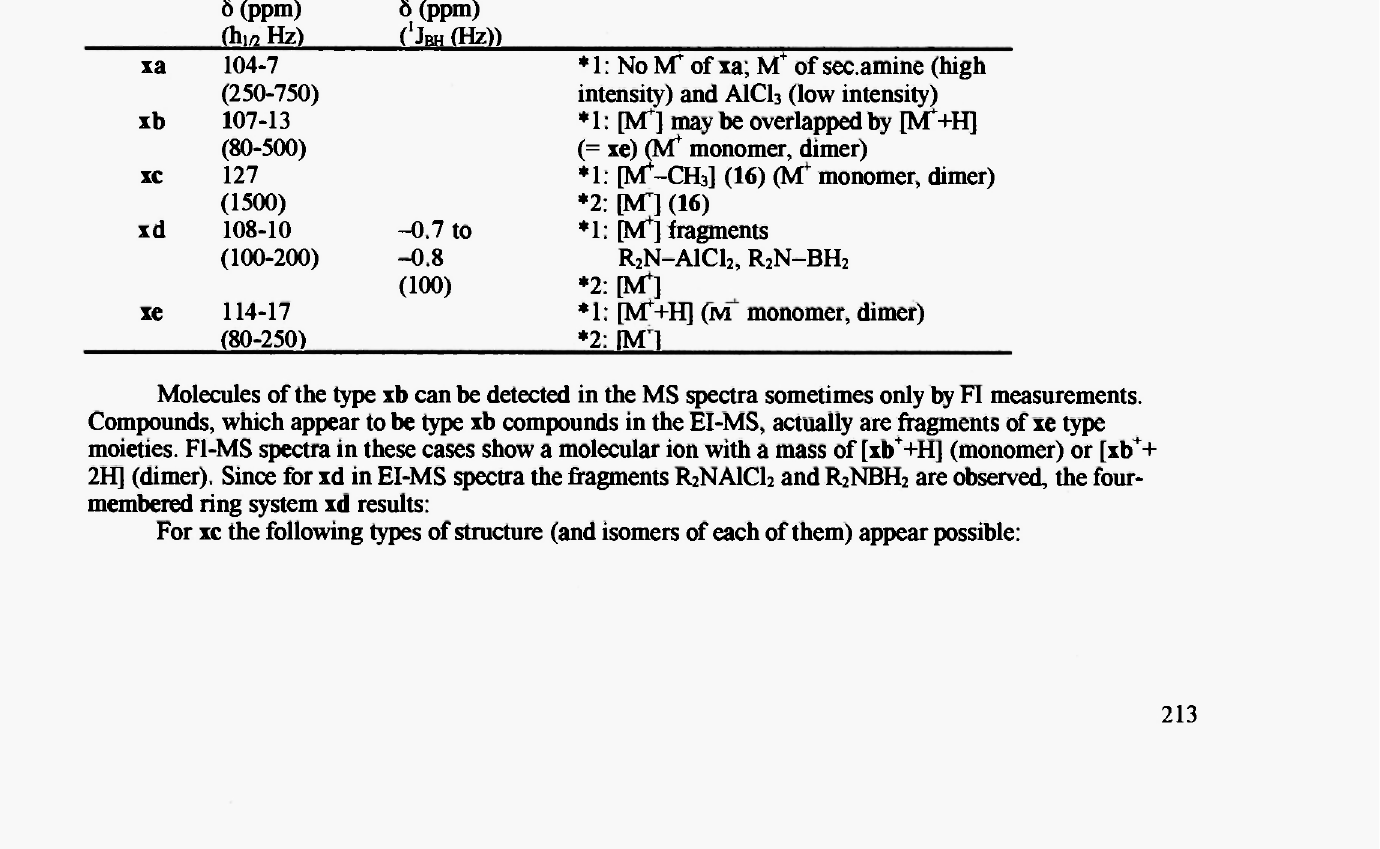
Table 3. 27 A1-NMR-, "B-NMR (xd only) and MS-Data of Al-Compounds